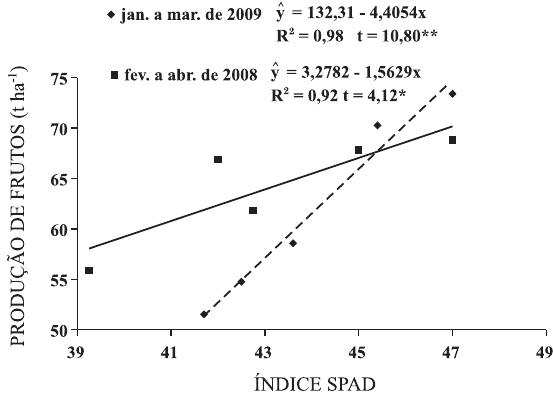
Figura 3. Correlação entre o índice SPAD e a produtividade de frutos em pomar de goiabeiras cultivar Paluma (colheita de fevereiro a abril de 2008 e janeiro a março de 2009); **, *: significativo a 1 e 5 %,